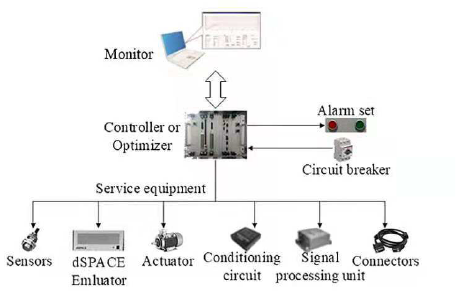
Figure 8. The simulation topology diagram of automatic train operation hardware-in-the-loop simulation (HILS)